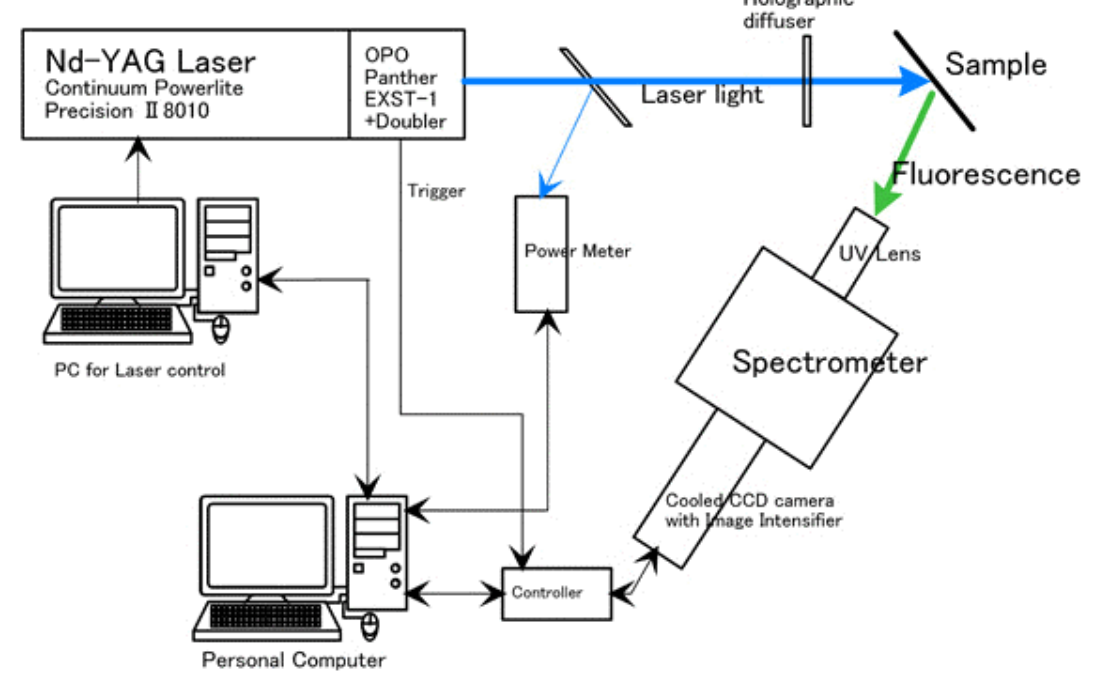
FIGURE 1. Block diagram of the time-resolving fluorescence imaging and spectroscopy